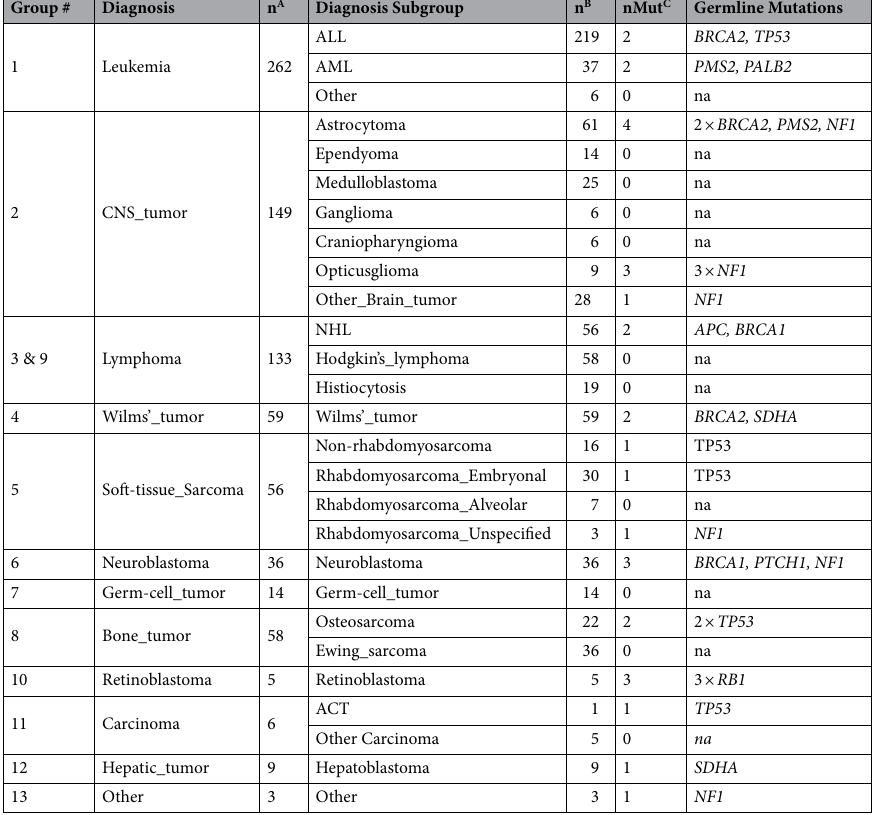
Table 2. Diagnosis distribution of LCCG cohort including subgroups with corresponding germline mutations . ALL acute lymphoblastic leukemia, AML acute myeloid leukemia, NHL non-Hodgkin’s lymphoma. A Number of patients within each main diagnosis group. B Number of patients in each diagnosis subgroup. C Number of (likely) pathogenic